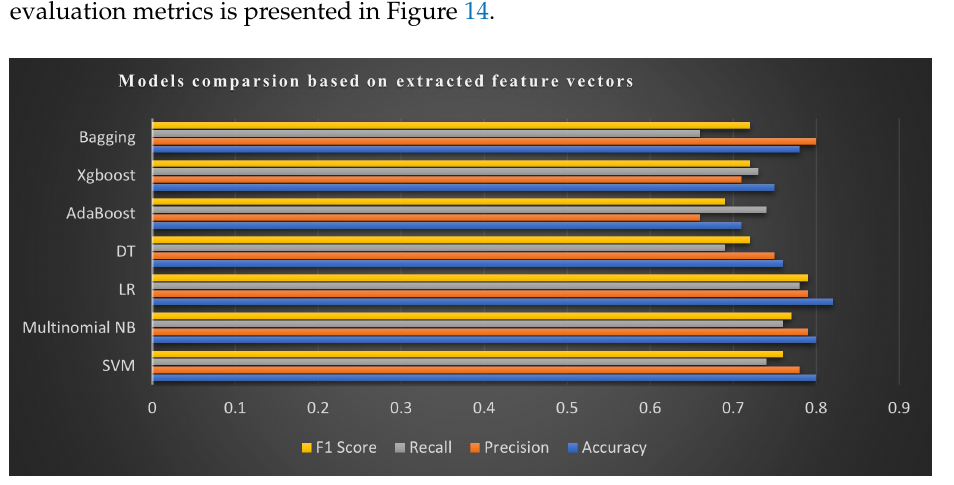
Figure 14. Proposed approach for detecting cyberbullying patterns in colloquial Roman